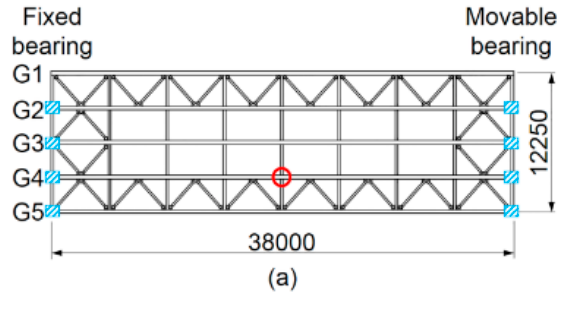
Figure 3. Cont. Figure 3.